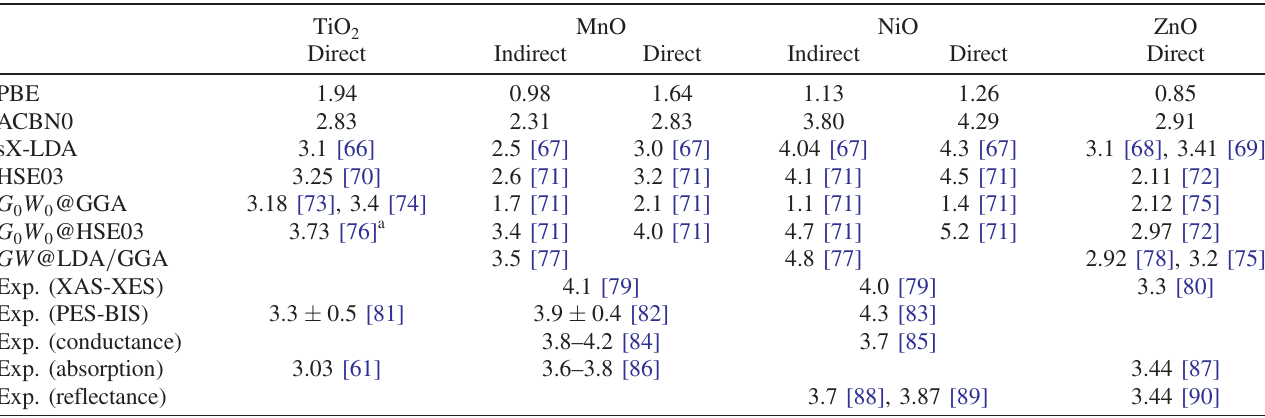
TABLE II. Minimum direct and indirect energy band gaps (in